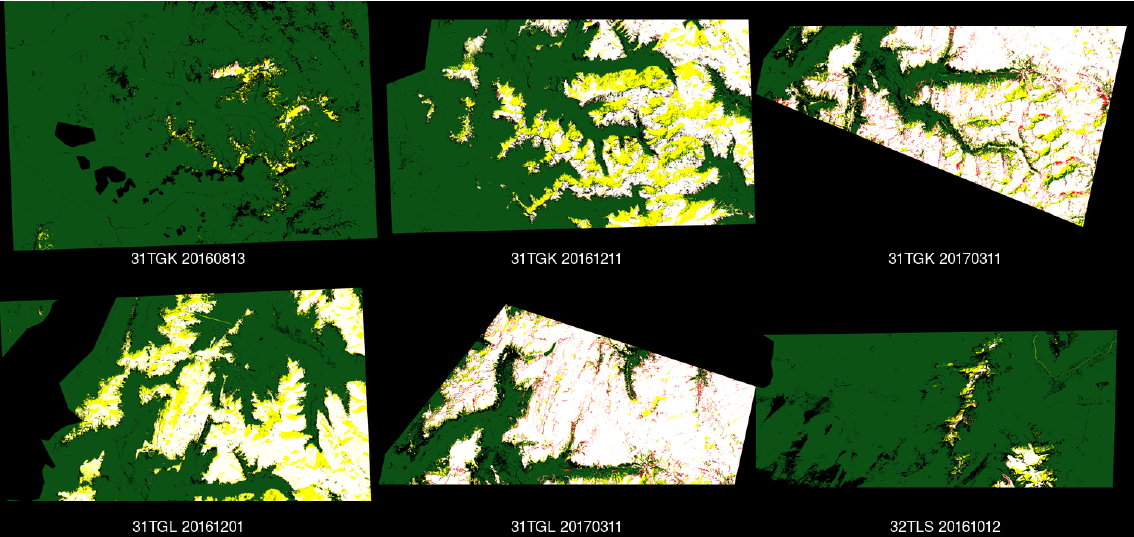
Figure A2. Sen2cor snow product vs. SPOT-6/7 snow maps (green: true negative, white: true positive, red: false positive, yellow: false